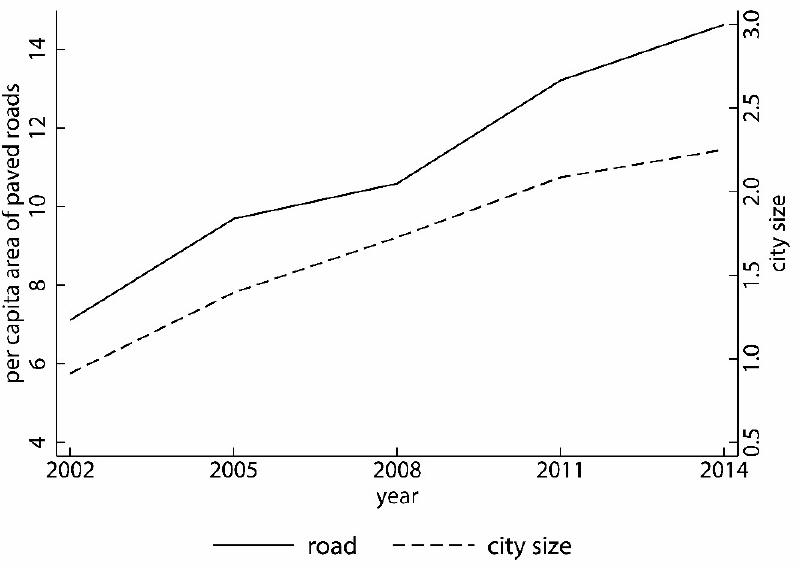
Figure 2. Trends in city size and per capita area of paved roads.